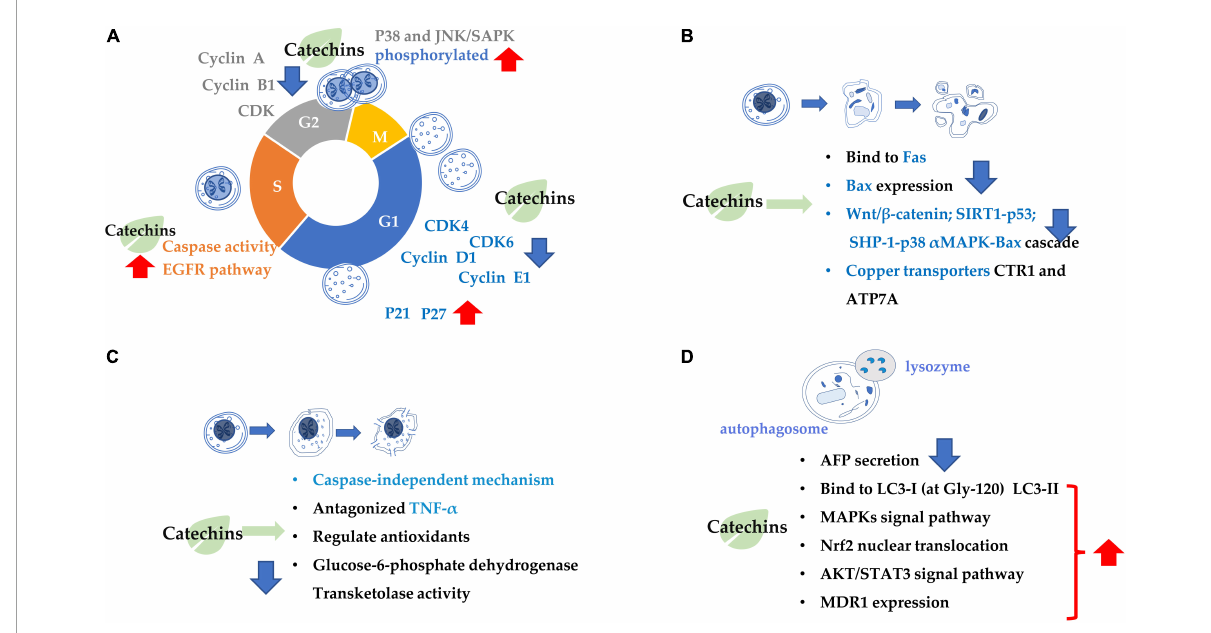
FIGURE1 Summary of the target of tea catechins inhibiting cancer cell proliferation and growth. This is mainly achieved through four processes: (A) cell cycle arrest; (B) cell apoptosis; (C) cell necrosis; and (D) cell autophagy. Blue arrows indicate downregulation and red arrows indicate